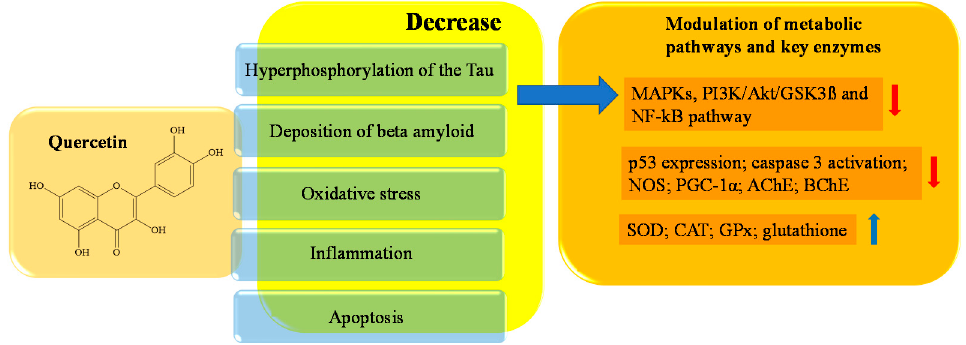
Figure 4. Schematic effects of quercetin on molecular targets of AD.